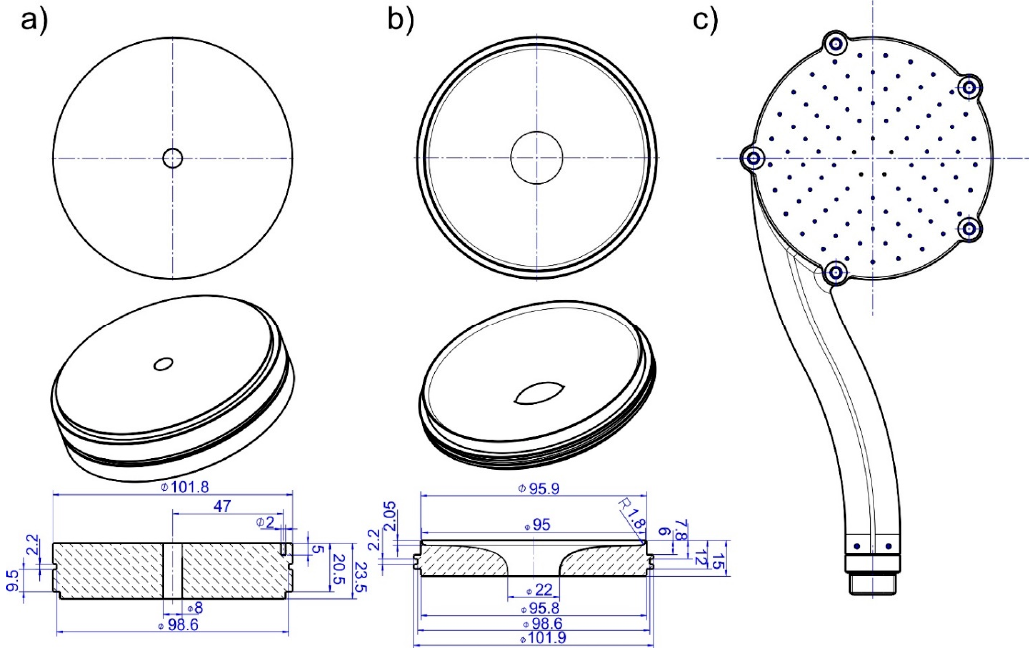
Figure 1. Schematics of the regular ( a ) and the vortex ( b ) showerhead. Both are encapsulated in the same handle and nozzle plate ( c ). The numbers in blue in subfigures ( a ) and ( b ) are the dimensions in mm.